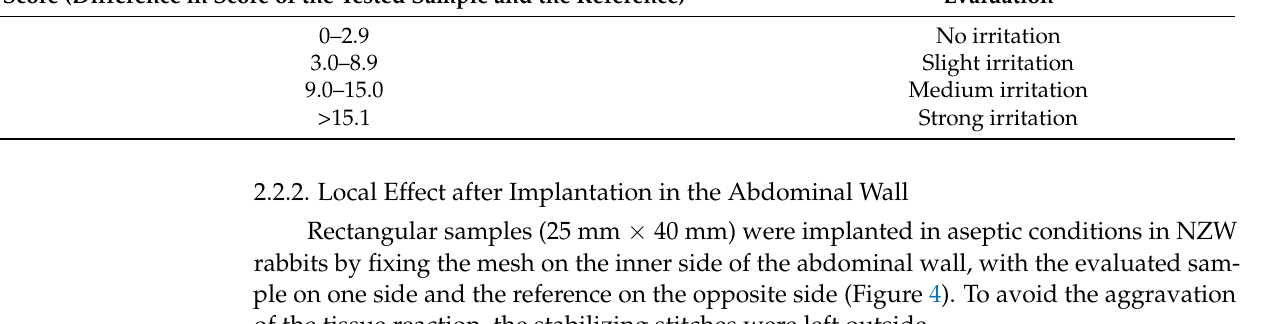
Table 2. The evaluation score for the general-response estimation of the tested implants. Score (Difference in Score of the Tested Sample and the